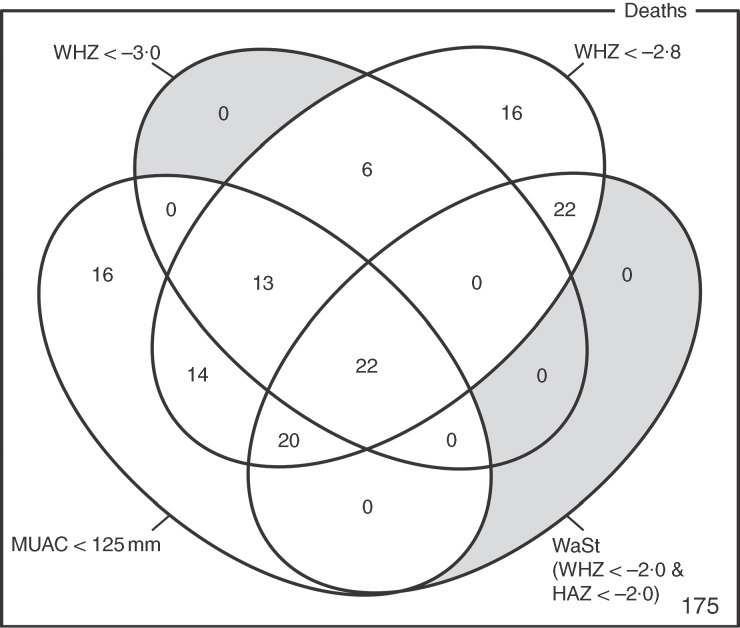
Numbers of deaths identified using MUAC < 125 mm, WHZ < −3·0, WAZ < −2·8 and WaSt case definitions among children aged 6–59 months in the Niakhar cohort data, rural Senegal(

22

). The shaded area shows cells outside the union of the MUAC < 125 mm and WAZ < −2·8 sets. MUAC < 125 mm or WAZ < −2·8 detected all deaths associated with WaSt and with WHZ < −3·0. MUAC < 125 mm or WAZ < −2·8 detected more deaths than MUAC < 115 mm or WHZ < –3·0 (MUAC, mid-upper arm circumference; WHZ, weight-for-height Z-score; WAZ, weight-for-age Z-score; WaSt, concurrent wasting and stunting; HAZ, height-for-age Z-score)